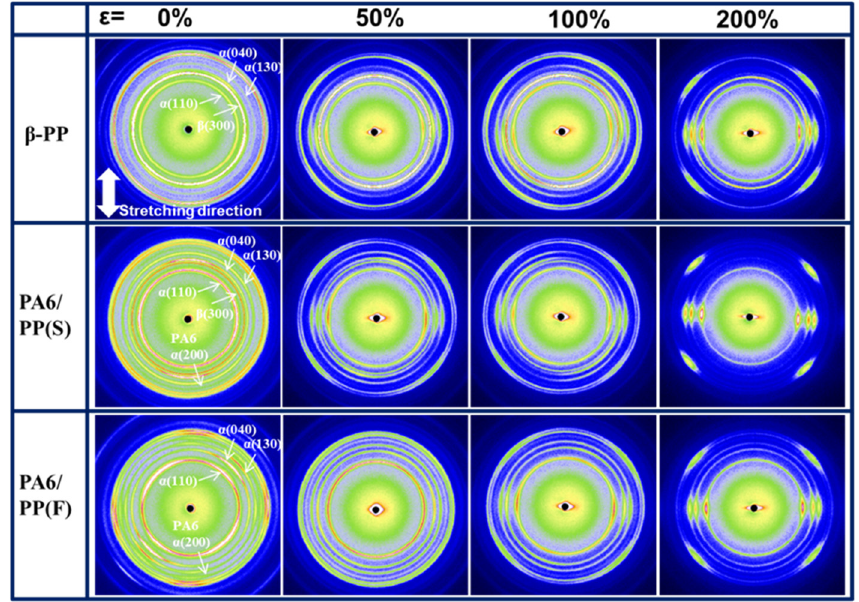
Figure 7. Two-dimensional-WAXD results of the structural evolution of longitudinally stretched β -PP, PA6/PP(S), and PA6/PP(F) films. The tensile temperature was 100 °C and the strains were 0%, 50%, 100%, and 200%.